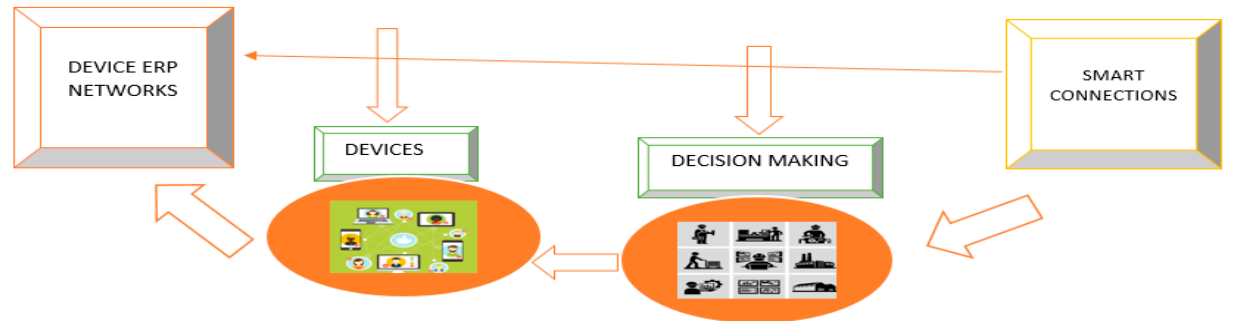
Figure 4. Natural language processing for industrial use.